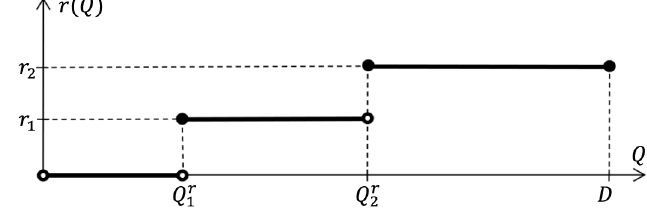
Figure 2. Step function of the discount r ( Q ) on purchase